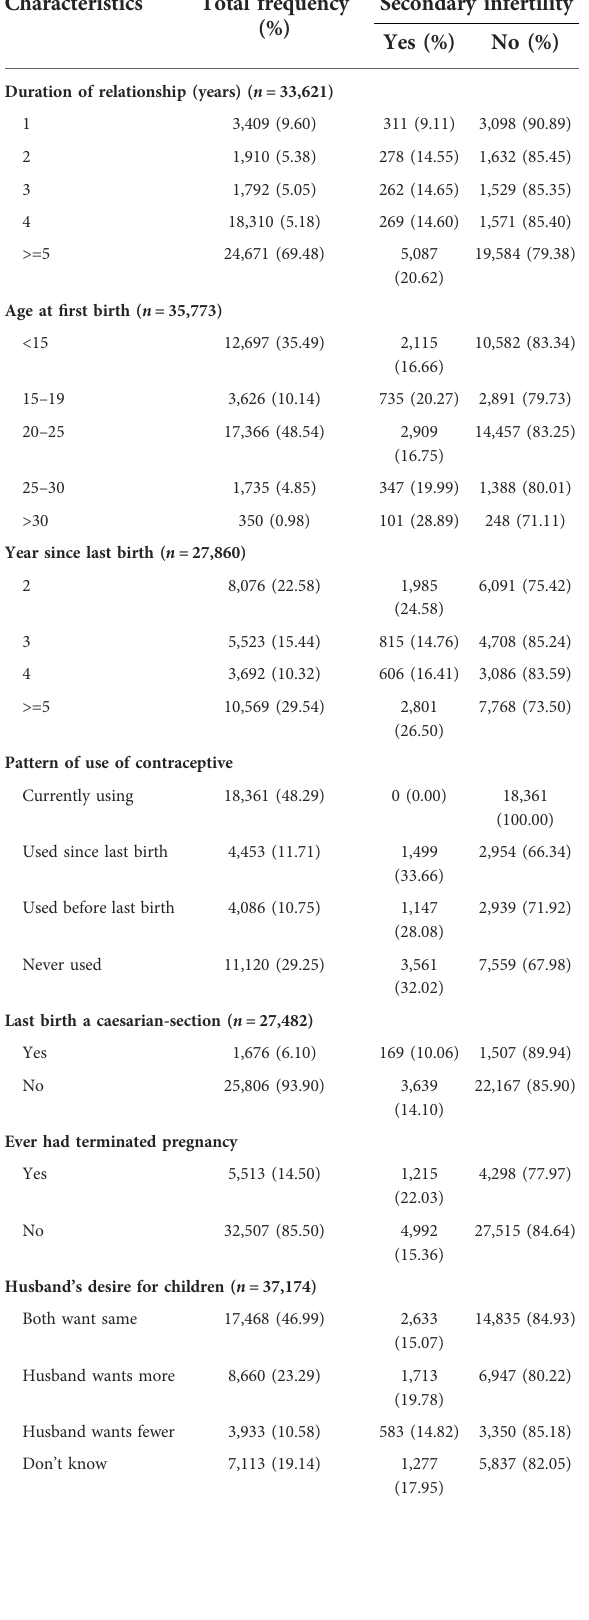
TABLE 3 Reproductive characteristics of women in East Africa ( n